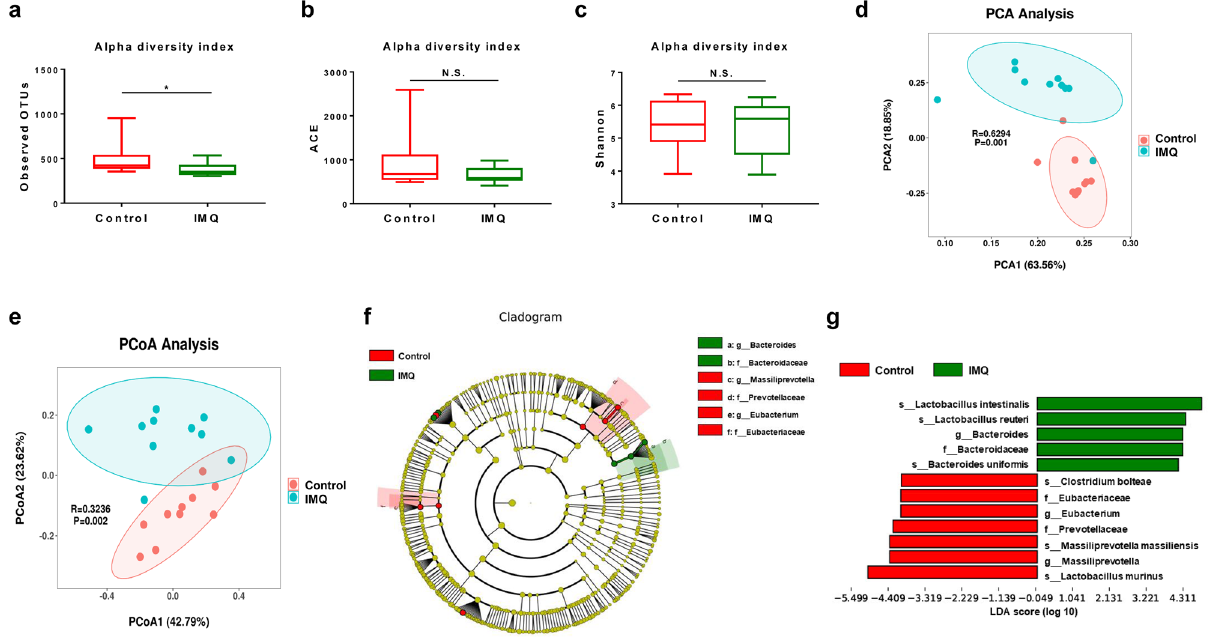
Figure 2. Effects of IMQ on the composition of gut microbiota in alpha-diversity and beta-diversity. ( a ) Alpha- diversity index of observed OTUs (Mann–Whitney U test, U = 21, P = 0.029). ( b ) Alpha-diversity index of ACE (Mann–Whitney U test, U = 21, P = 0.353). ( c ) Alpha-diversity index of Shannon (Mann–Whitney U test, U = 45, P = 0.739). ( d ) PCA of beta-diversity based on the OTU level (ANOSIM, R = 0.6294, P = 0.001). Each point represents a single sample which is color-coded according to group, and the two principal components (PC1 and PC2) explained 63.56% and 18.85%. ( e ) PCoA plot using weighted UniFrac distance (ANOSIM, R = 0.3236, P = 0.002). Each point represents a single sample and the two principal components (PCoA1 and PCoA2) explained 42.79% and 23.62%. ( f ) LEfSe cladogram (LDA score > 4.0, P < 0.05) indicated differentially abundant taxa between control group and IMQ group. Each circle represents the taxonomic categories from the species level as the outermost circle to phylum level as the innermost cycle. ( g ) Histograms revealed differentially abundant taxa with LDA score (log10) > 4.0 and P < 0.05 between the control group and IMQ group. The LDA scores of the control group was negative, while those of the IMQ group was positive. The values represent the mean ± S.E.M. (n = 10). * P < 0.05. N.S.: not